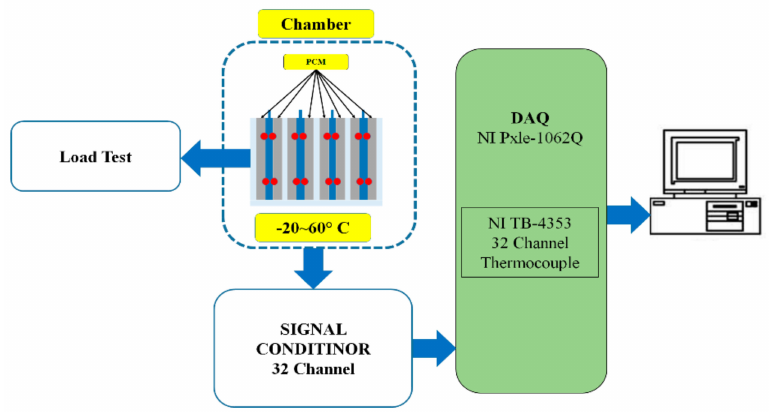
Figure 3. Schematic representation of test setup for Li polymer pouch battery